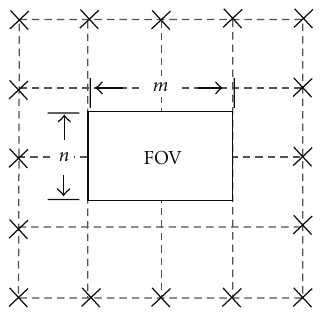
Figure 4: Optode geometry for CCD-camera-based DOT system. The dimension of FOV was m × n in mm 2 . X represents possible locations of source